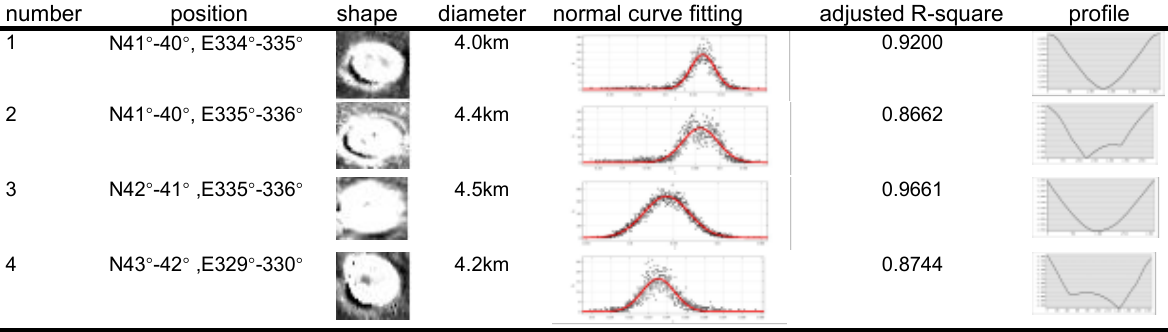
Table 1. A comparison of 4 impact craters whose diameters are about